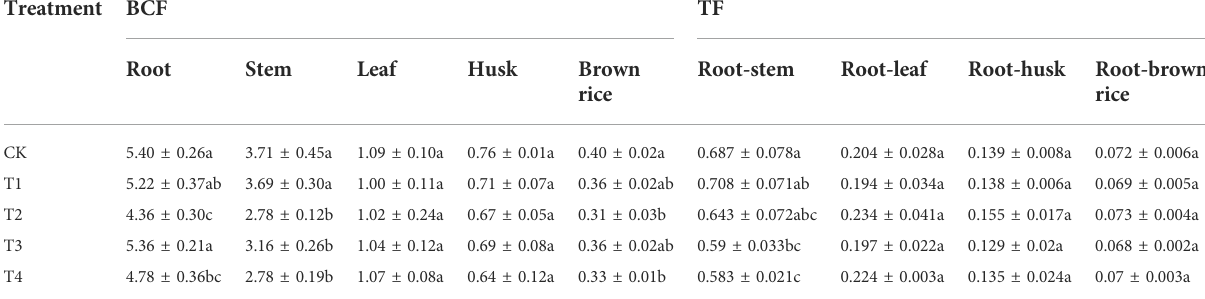
TABLE 2 Translocation factors and bioconcentration factors of Cd in rice. Treatment